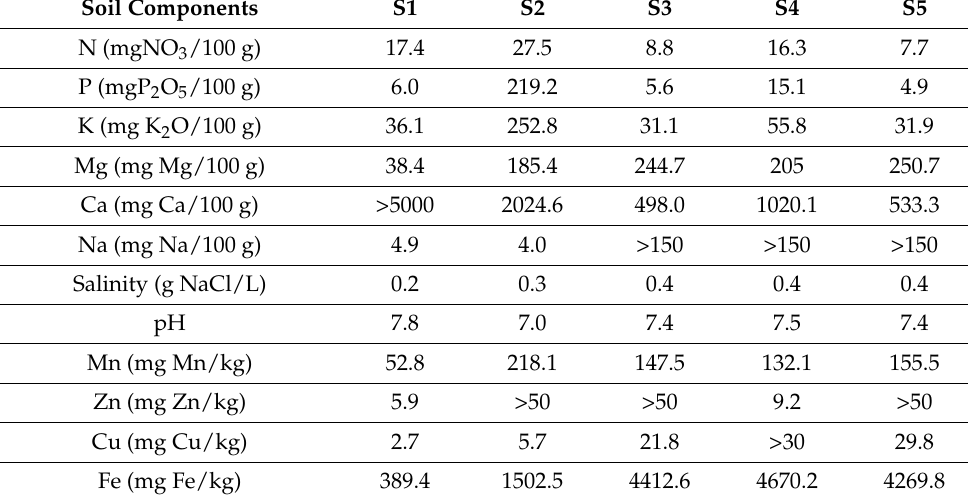
Table 2. Soil component